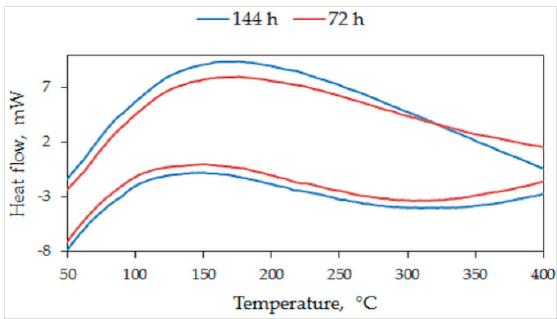
Figure 7. DSC curves of: Samples S1050a3 and S1050a4.